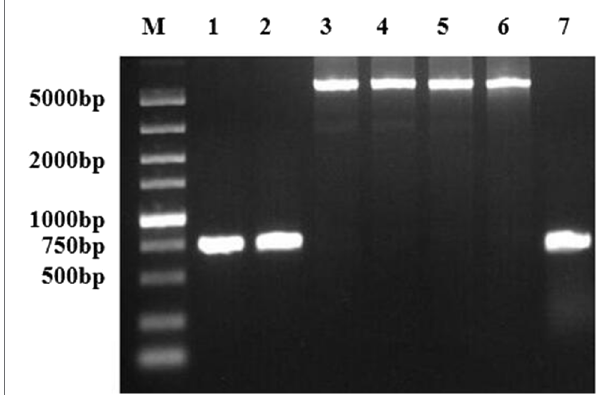
FIGURE 3 | PCR detection of the region between panB and Cj0299 in various strains. Lanes 1 and 2, PCR products from aminoglycoside- susceptible strains 28 and 31, respectively; Lanes 3 and 4, PCR products from the C. jejuni transformants of NT-165 and NT-254, respectively; Lanes 5 and 6, PCR products from aminoglycoside-resistant strains 165 and 254, respectively; and Lane 7, PCR products from C. jejuni NCTC11168.